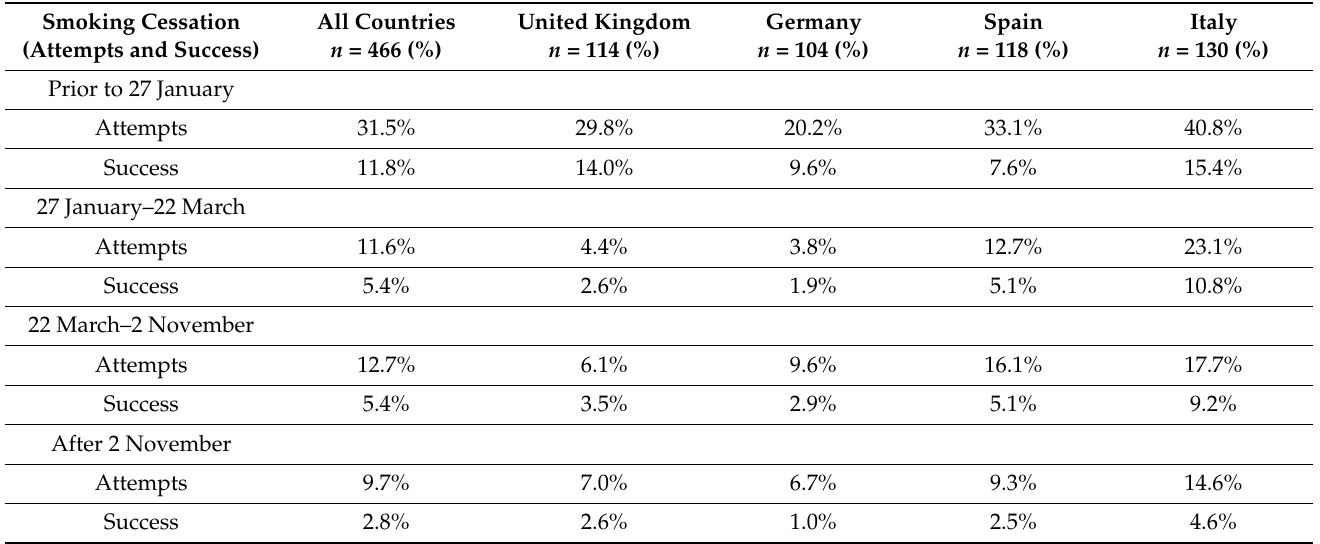
Table 2. Smoking cessation attempts within the smoker subgroup, n =